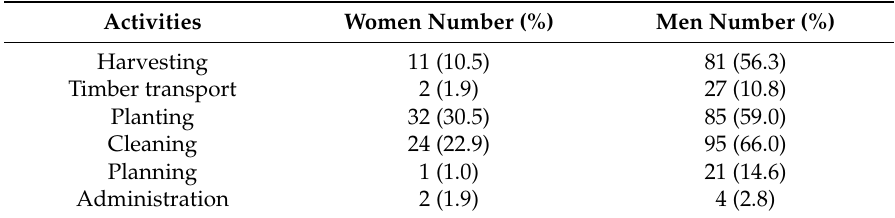
Table 5. The number and proportion of men and women who helped their parents with the management of the estate according to their activities.